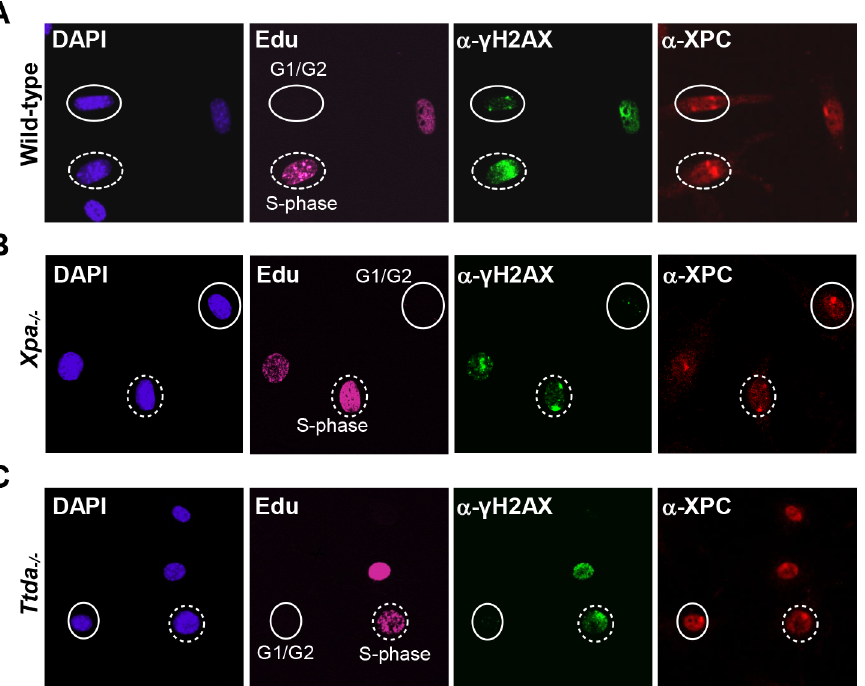
Figure 3. c H2AX signaling is abolished in Ttda 2 / 2 MEFs. Cell cycle dependent analysis of XPC and c H2AX recruitment to local UV-damage in wild-type (A), Xpa 2 / 2 (B) and Ttda 2 / 2 (C) MEFs. Cells were seeded on cover slips and the next day irradiated with 60 J/m 2 through a filter containing 5 m m pores and subsequently labeled with EdU for 1 hour. After fixation cells were assayed for DNA synthesis using EdU and Alexa Fluor 647 azide (cell cycle marker, pink) and by immuno-fluorescent staining using antibodies against c H2AX (green) and XPC (red). Dashed circles indicate typical examples of cells in S-phase, closed circles indicate typical examples of G1/G2 cells.